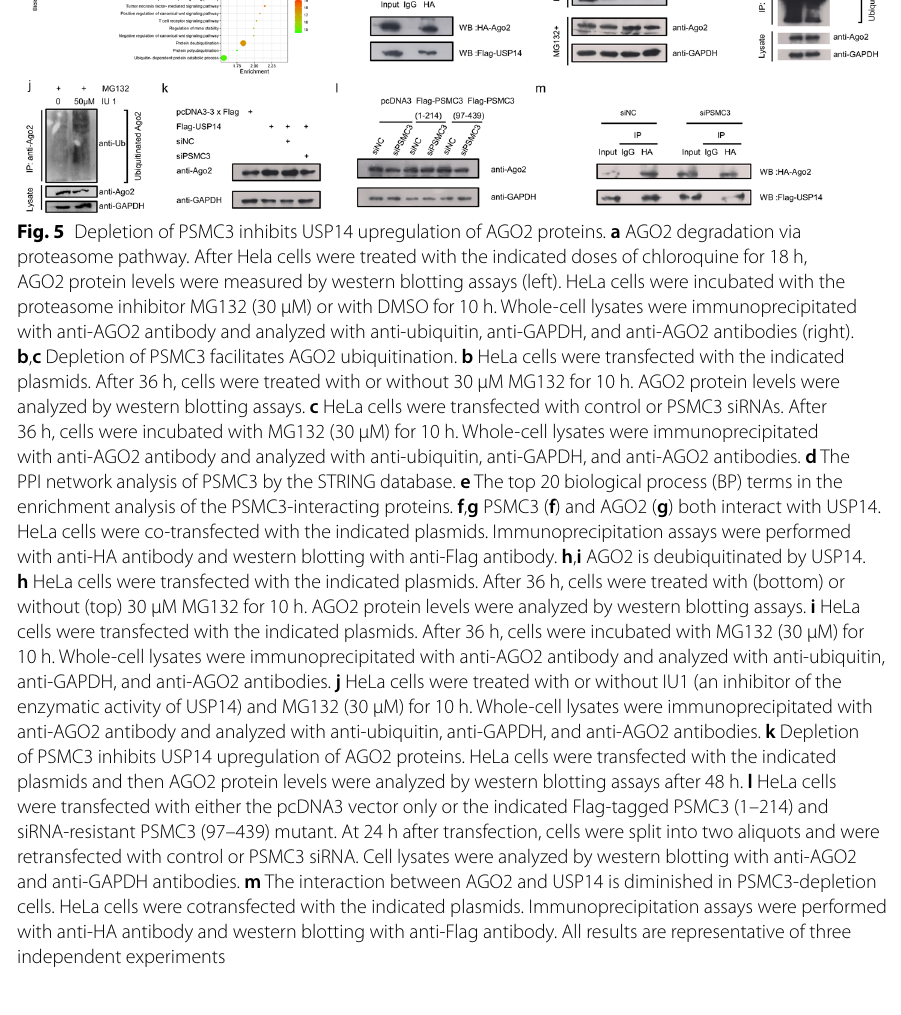
ligase mLin41 (mouse homolog of lin41) [50]. So, we examined the degradation pathway of AGO2 protein by using the lysosomal inhibitor chloroquine or the proteasome inhibi- tor MG132. Upon treatment with MG132 but not chloroquine, high-molecular-weight forms of AGO2 accumulated (Fig. 5a), indicating that AGO2 was ubiquitinated in vivo. To further identify the ubiquitination sites of AGO2 , two ubiquitin site prediction algo- rithms, BDM-PUB (http:// bdmpub. biocu ckoo. org/ predi ction. php) and UbPred (http:// www. ubpred. org/) were used, which predicted that the C-terminal region of AGO2 con- tains five lysine residues that are potential targets for ubiquitination (Additional file 1: